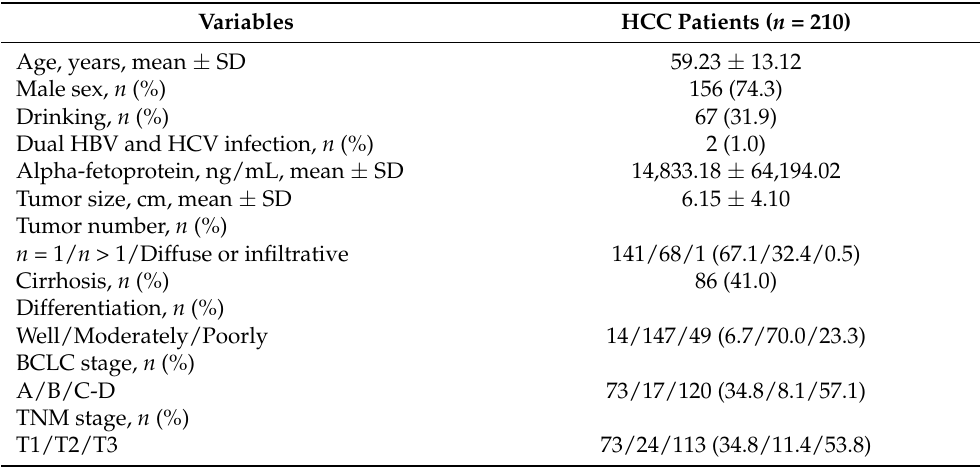
Table 1. Clinical characteristics of the 210 patients with hepatocellular carcinoma (HCC).